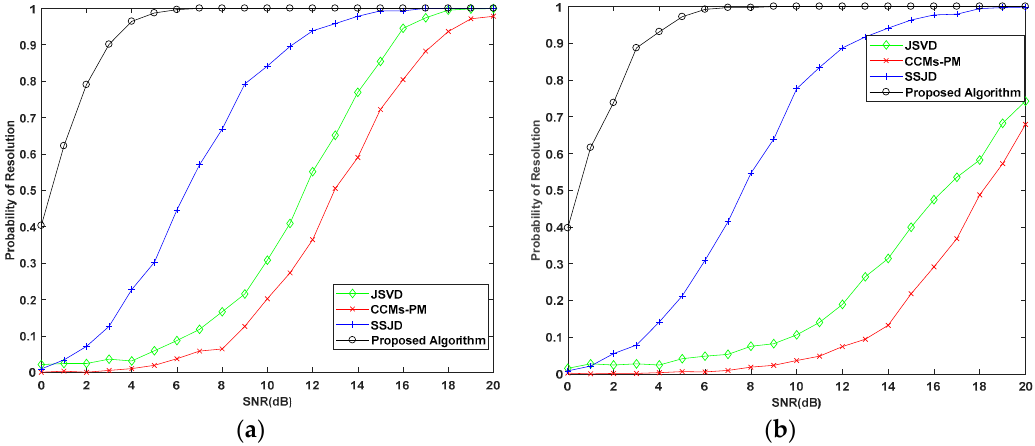
Figure 13. Probability of Resolution versus SNR for di ff erent sensor spacing ( a ) d = 0.5 λ ; ( b ) d = 0.4 λ .